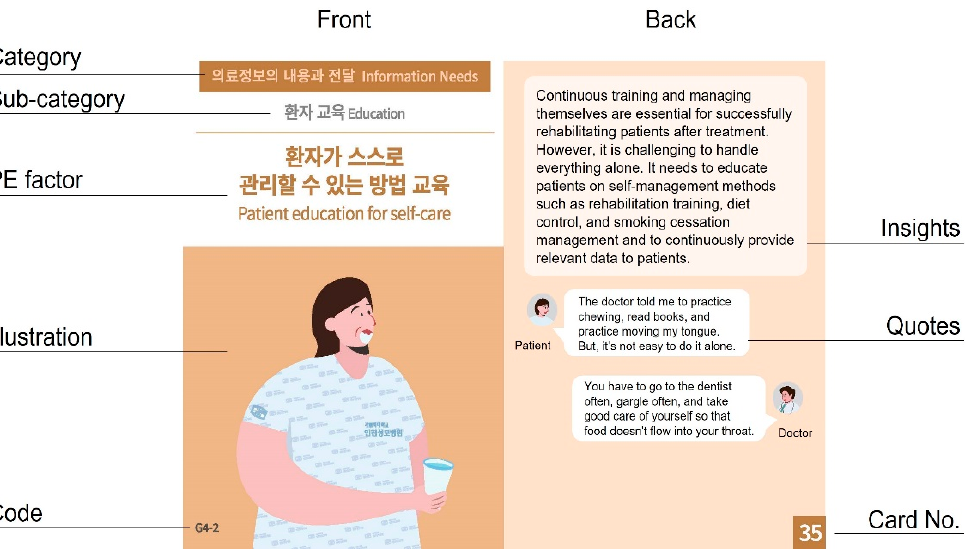
Figure 2. Design layout of Pat Exp Insight Cards for patients with HNC.